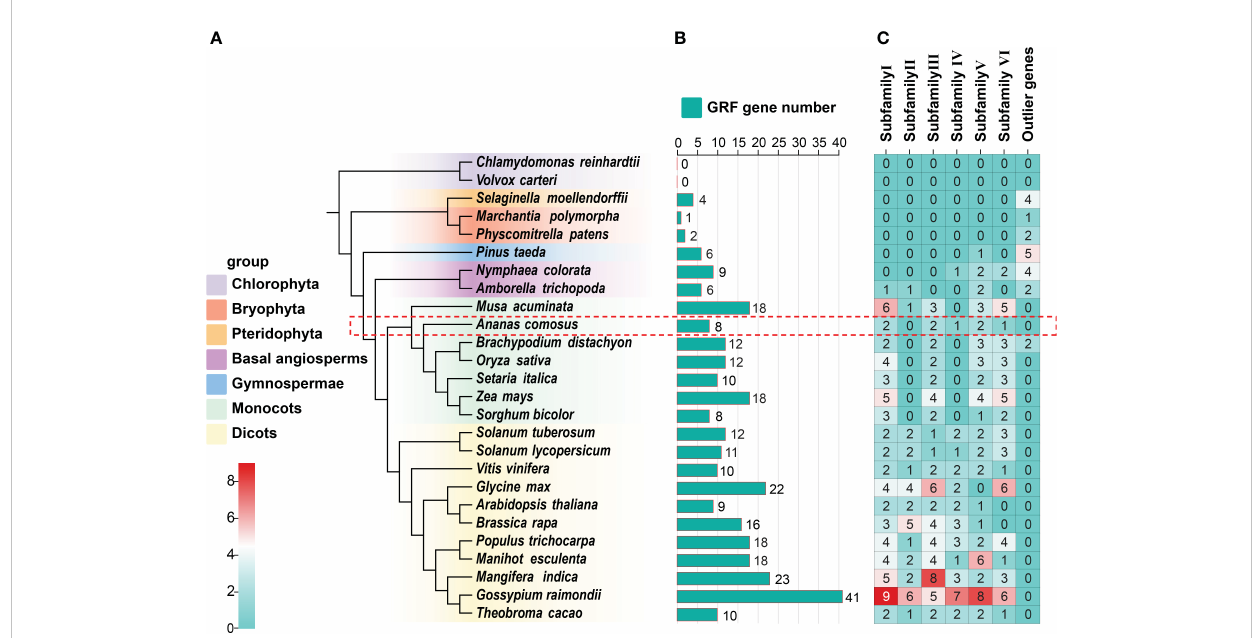
FIGURE 2 Evolutionary relationships among 26 species and their GRF gene compositions. (A) Phylogenetic relationships among 26 species. (B) Numbers of GRF genes in different species. (C) Distribution of GRF genes in various subfamilies. Phylogenetic analyses of 26 species were performed using OrthoFinder (Emms and Kelly, 2019). The GRF genes in pineapple are marked with a red rectangular